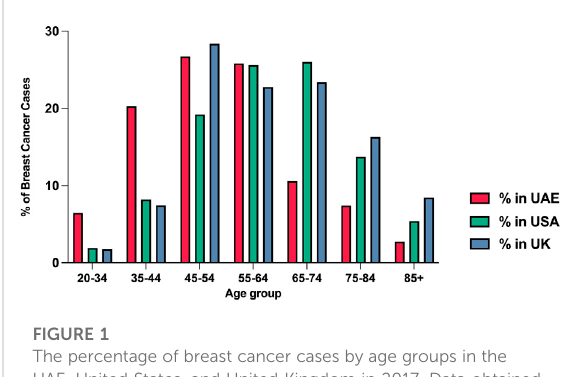
FIGURE 1 The percentage of breast cancer cases by age groups in